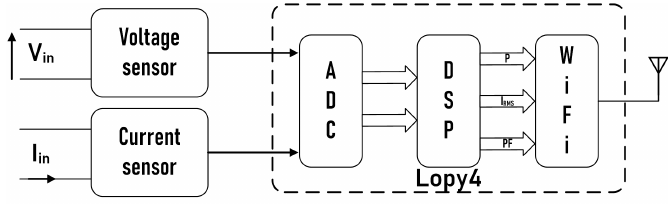
Figure 1. Block diagram of the realized sensor